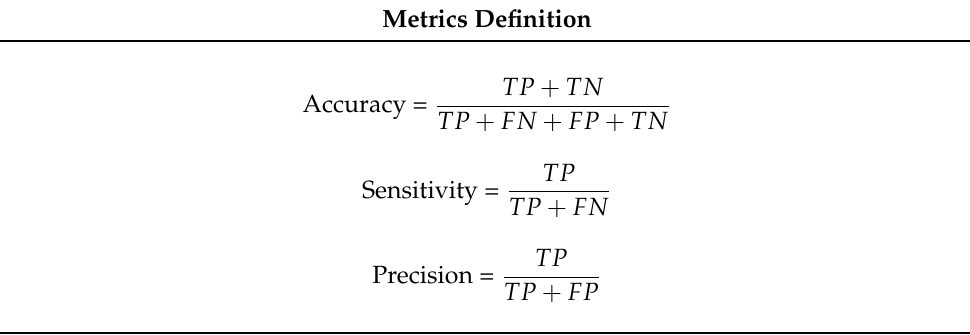
Table 1. Definition of metrics used to compare the classification